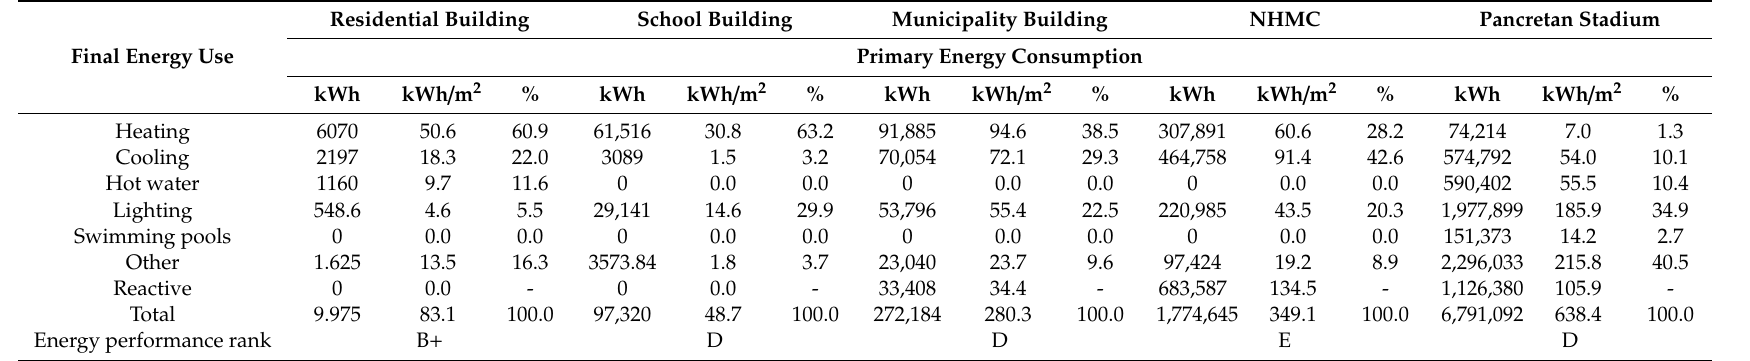
Table 4. Primary energy consumptions in the examined buildings in their current